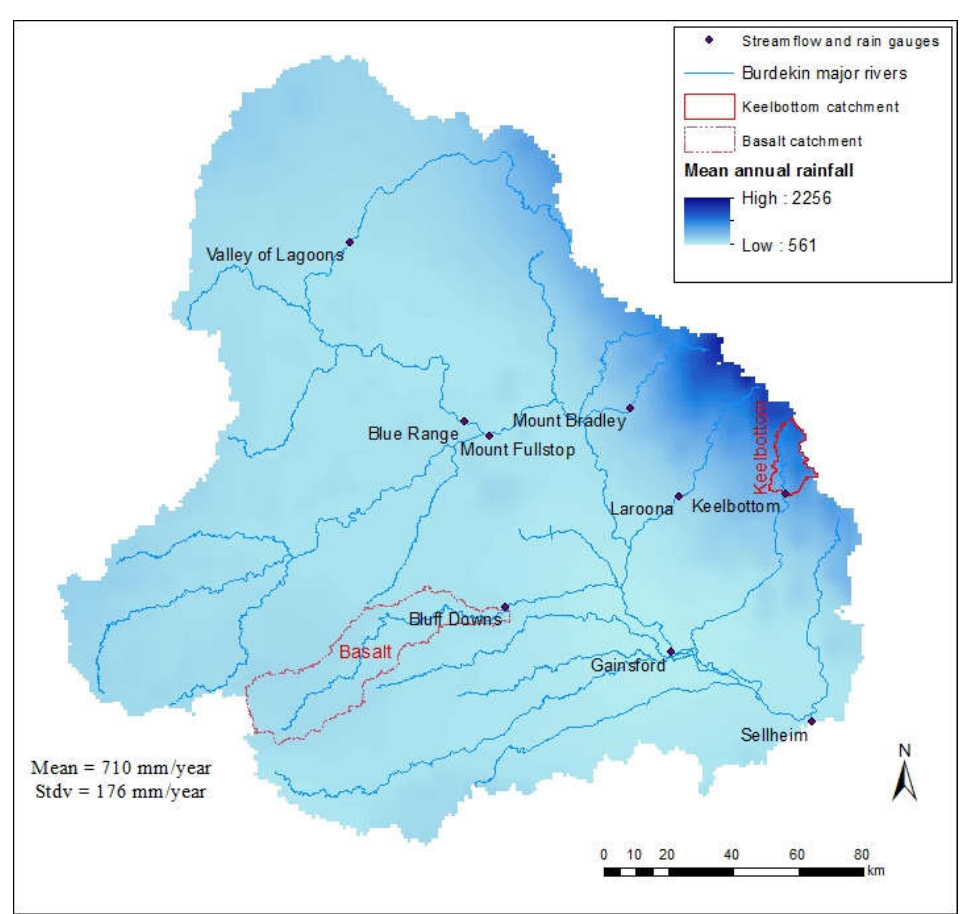
Figure 2. Distribution of long term (1889–2016) annual rainfall of Upper Burdekin catchment. This map is based on daily gridded 5 × 5 km rainfall data from SILO.